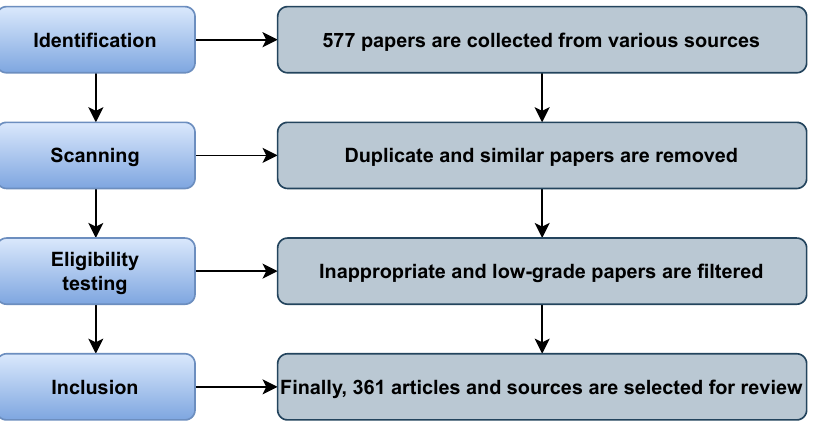
Figure 1. The PRISMA process that is followed in this